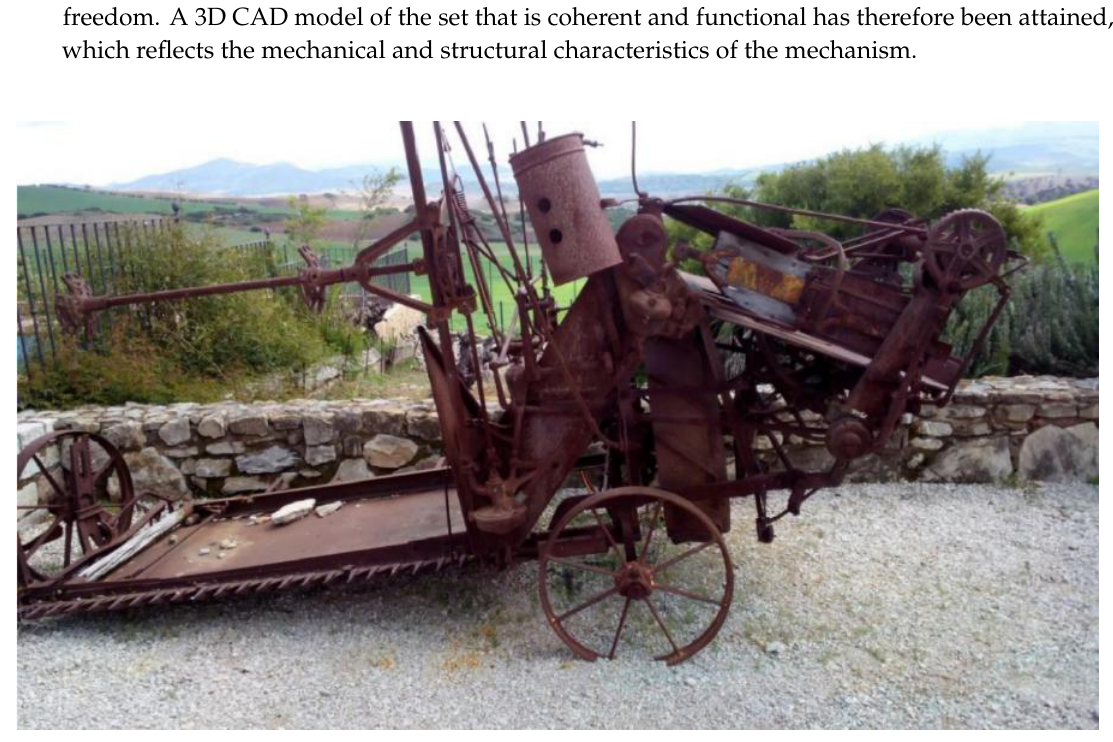
Figure 1. Photograph of the reaper-binder in its state of abandonment.